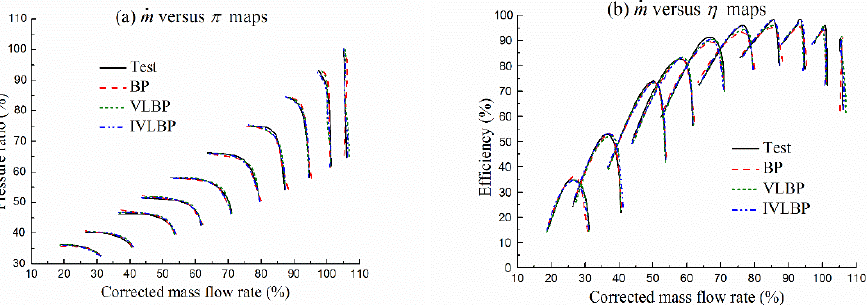
Figure 9. The prediction results of the MLP NNs.